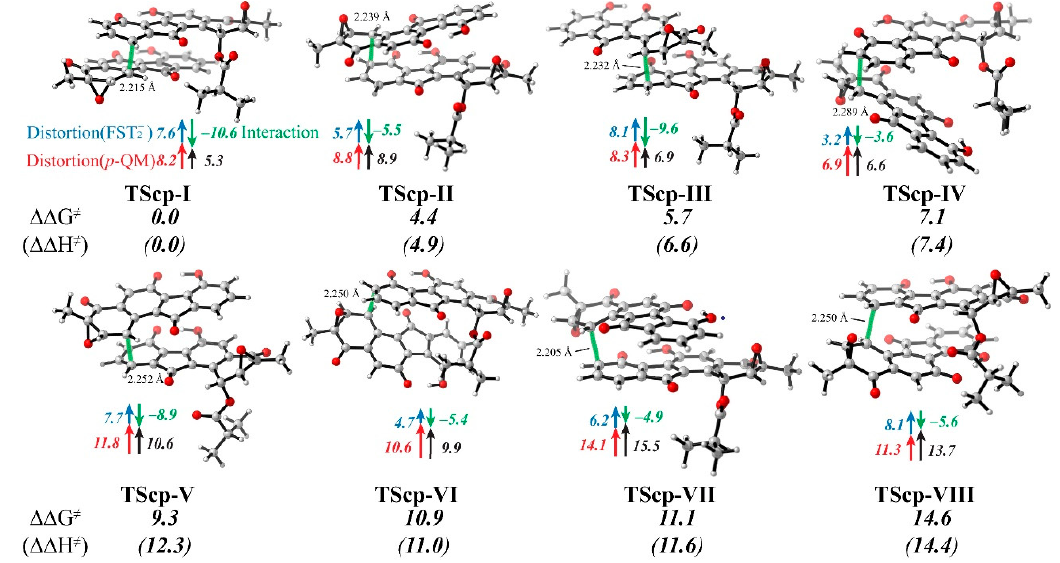
Figure 6. The calculated structures of TScp. (Bond lengths of the partially forming C–C bond are labeled, and the total energy change between pre-reaction state (CMPs) and transition states (TScp) are marked in black color, which consists of changes in the distortion energy of FST 2 − (blue), the distortion energy of p -QM (red), and the additional interaction energy for the C–C coupling.)